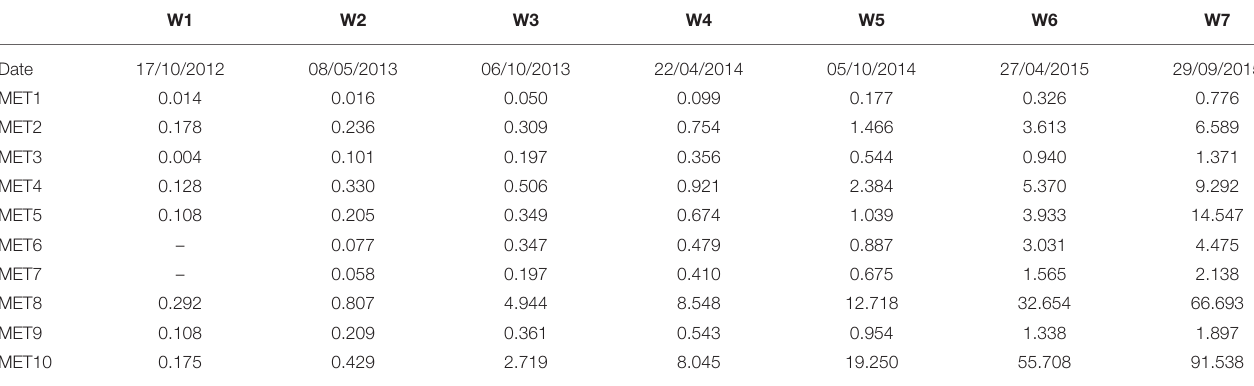
TABLE 1 | Metastases sizes measured by CT scans of the patient, at different times marked W1–W7. W1 W2